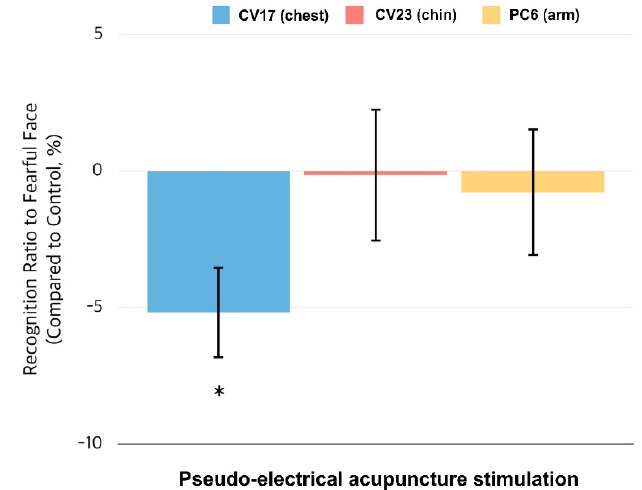
Figure 2. Proportion of faces classified as fearful compared with the control condition. We com- pared the proportion of faces classified as fearful in the three experimental conditions with that in the control condition. Only the CV17 (chest) condition elicited a significantly smaller ratio of fear- ful face classifications compared to the control condition. * p < 0.05.